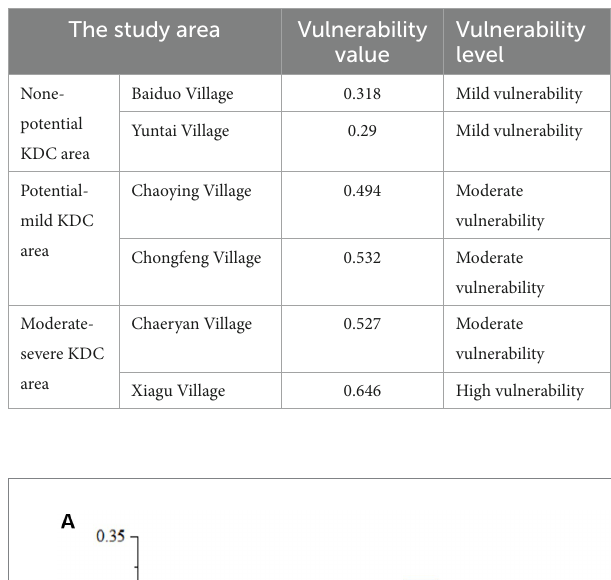
TABLE 2 Village ecosystem vulnerability